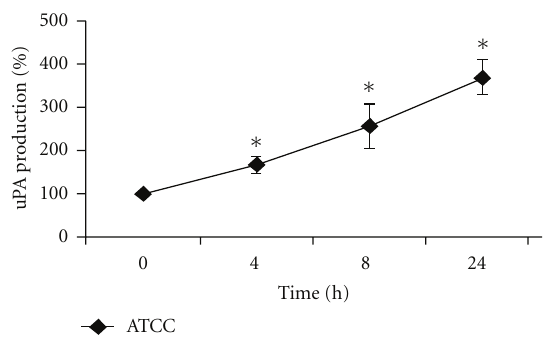
Figure 5: Time course of uPA production by HCAEC coincubated with GBS. uPA released from HCAEC was determined in the cell culture supernatants by ELISA as described in section 2. Data shown represent mean production in percent ± SEM of 3 independent experiments. The unstimulated control is defined as 100 percent. ∗ Indicates statistical significant di ff erence ( P < .